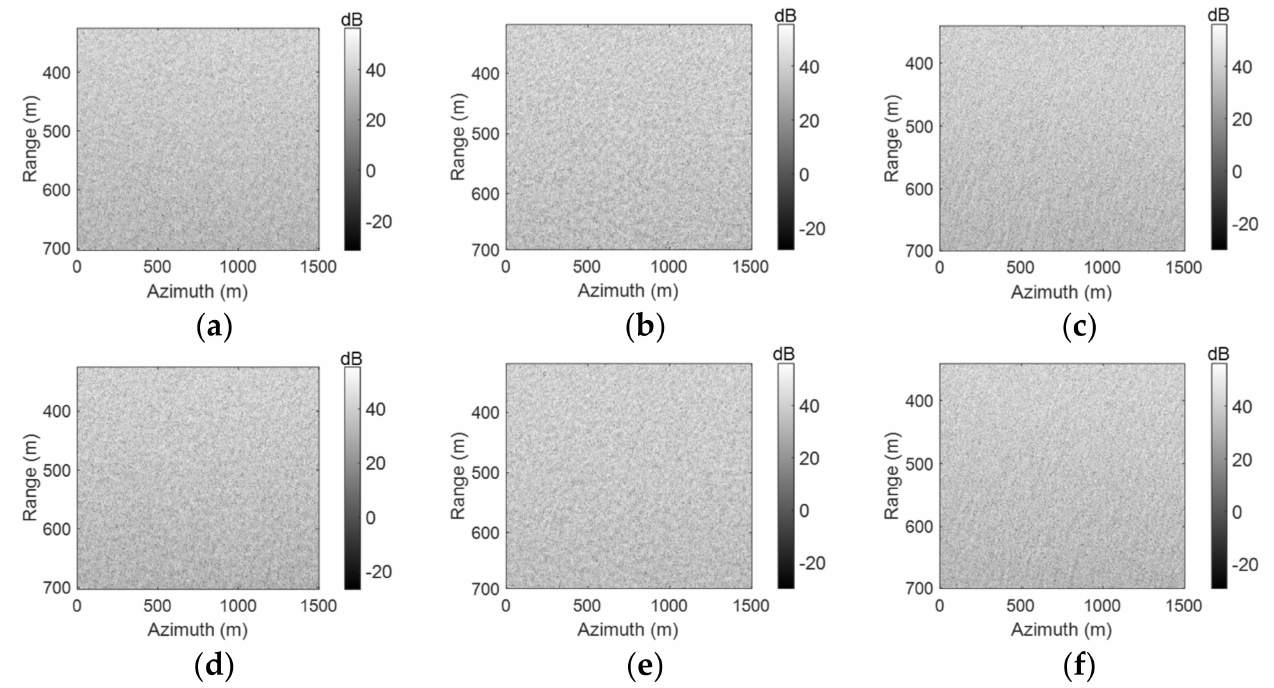
Figure 5. Master and slave IRA images. ( a , d ) Master and slave IRA images RZ14. ( b , e ) Master and slave IRA images of data RZ16. ( c , f ) Master and slave IRA images of data RZ24.